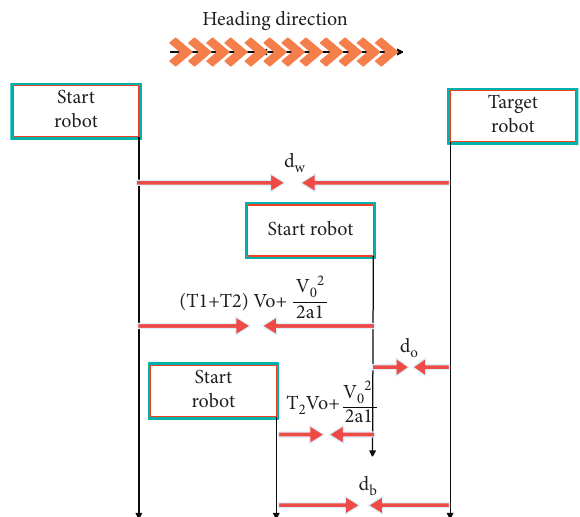
Figure 6: Schematic diagram of the distance between two